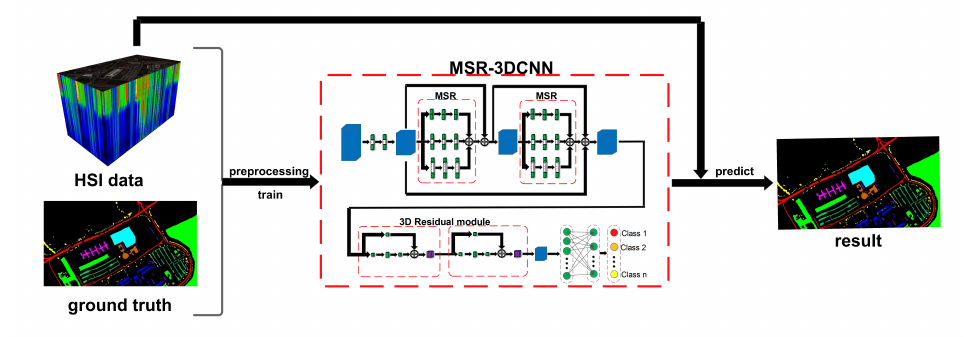
Figure 8. The training procedure of our